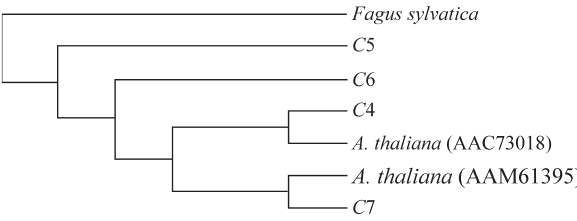
and 7 with chorismate mutase from Fagus sylvatica (ABA54871), Arabidopsis thaliana (AAC73018) and Arabidopsis thaliana